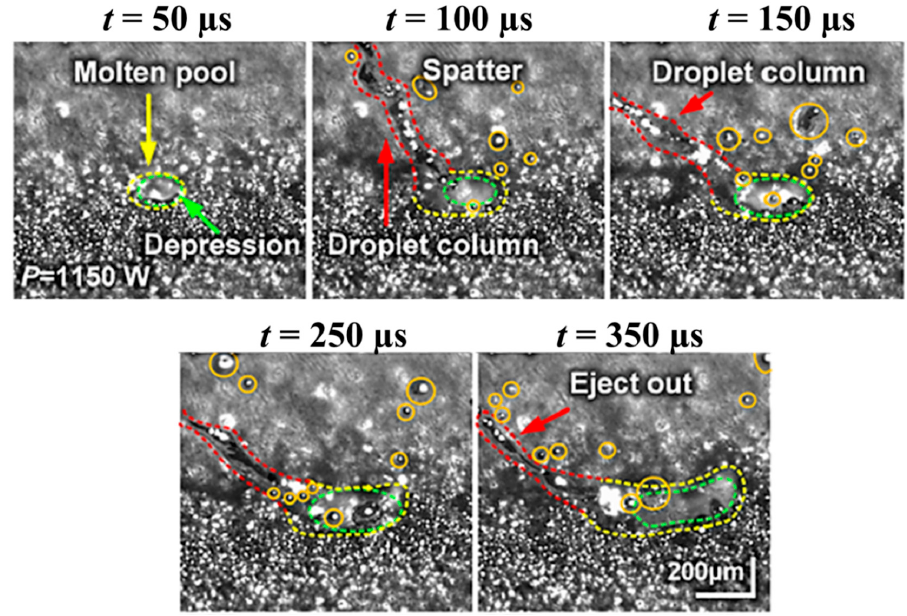
Figure 7. Time-series snapshots of the evolution of the molten pool in LPBF as a function of the laser power. A column of droplets oscillates and eventually breaks up into spatter particles at the rear of the molten pool with a laser power of 1150 W (Inconel 718 powder). Adapted from Reference [133] with permission from Elsevier.